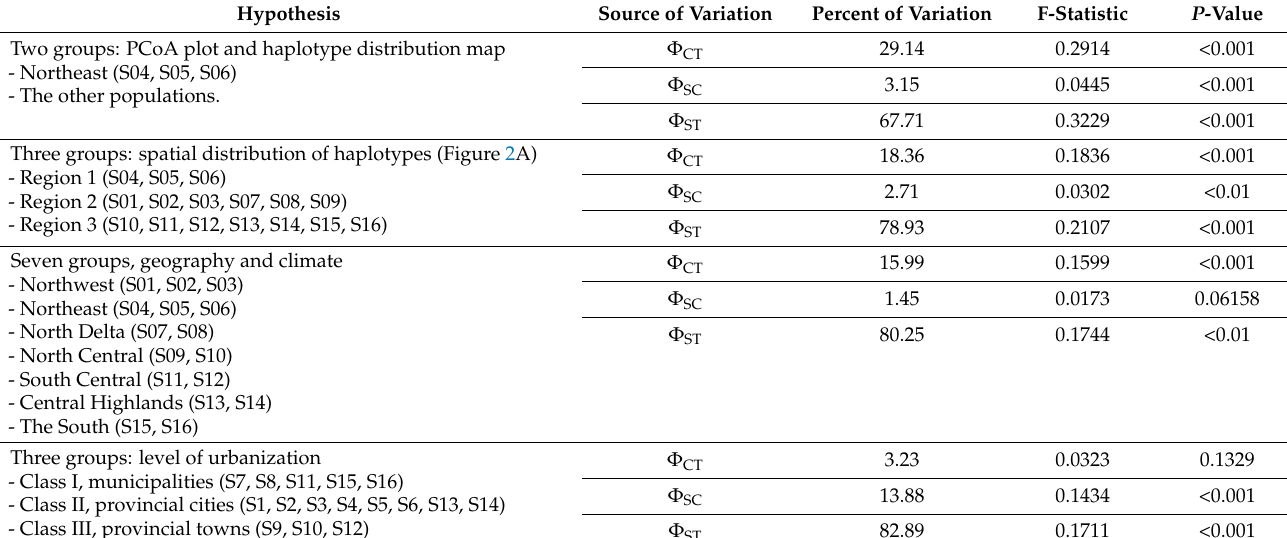
Table 2. Analysis of molecular variance (AMOVA) testing of hypotheses for the partitioning of genetic variation among Ae. albopictus populations in Vietnam. Hypothesis Source of Variation Percent of Variation F-Statistic P -Value